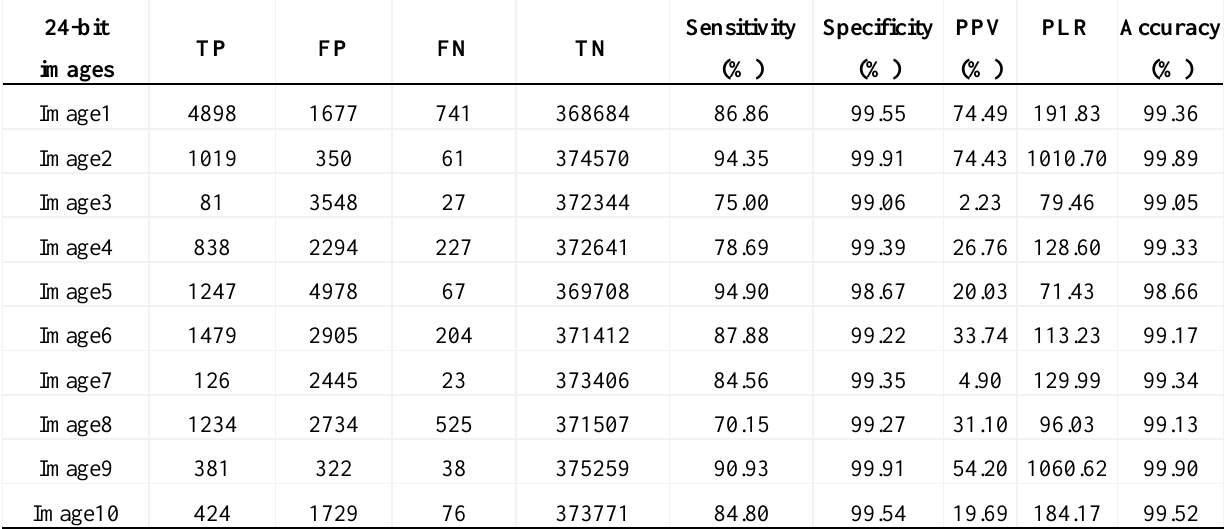
Table 1. The example results of exudates detection from FCM clustering followed by morphological operator